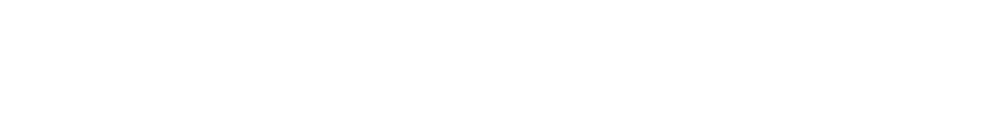
Frontiers in Physiology | Systems